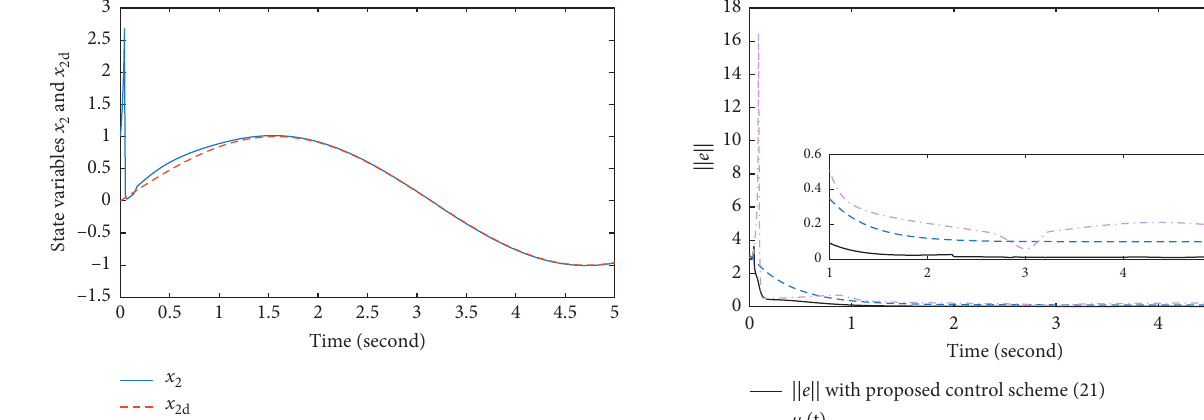
Figure 9: ‖ e ‖ with control schemes (20) and